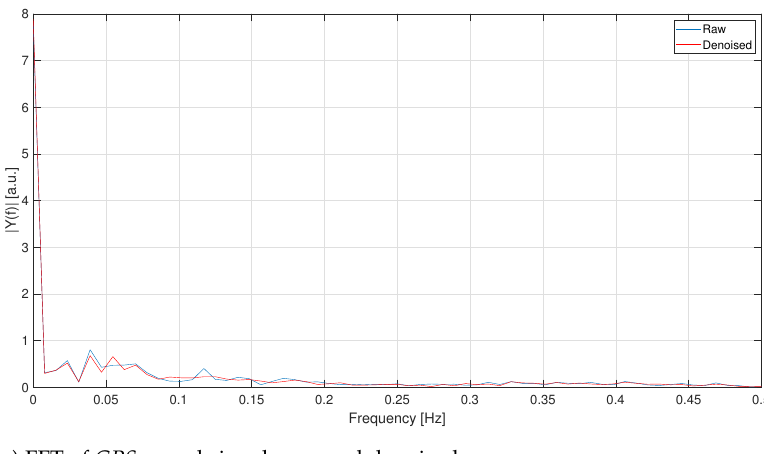
Figure 4. C1—Comparison between raw and denoised signals for the VBOX.